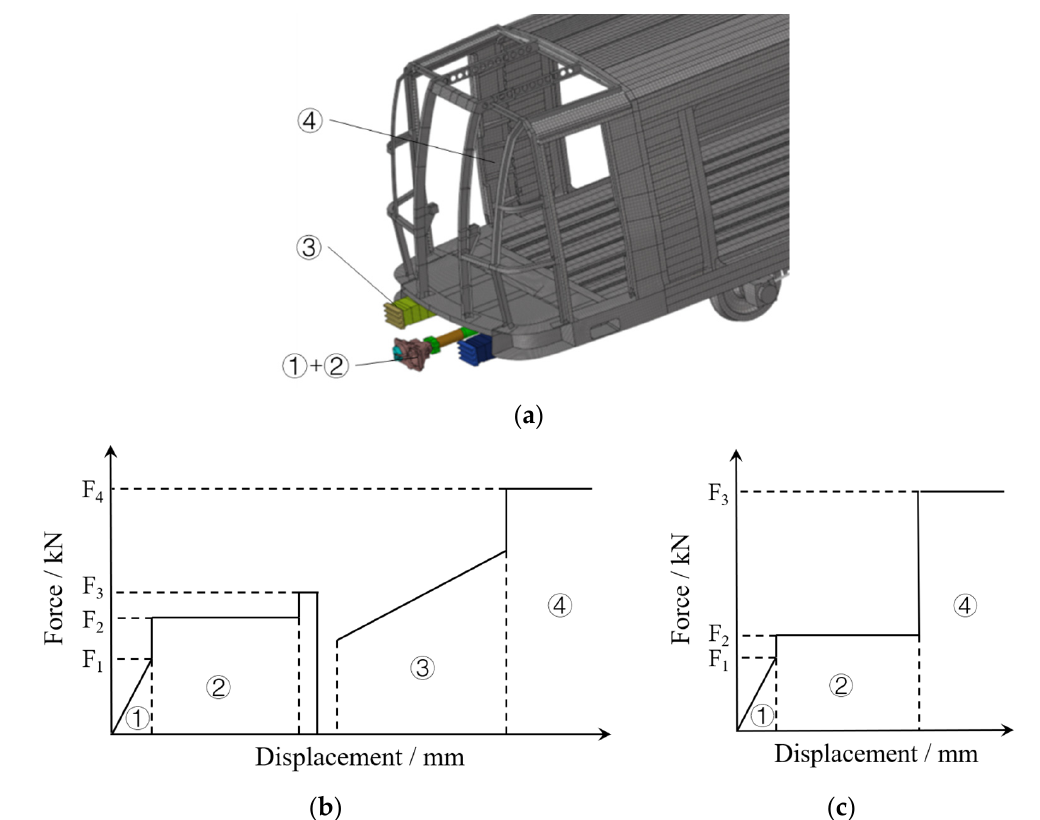
Figure 1. Energy absorption sequence of energy-absorbing structures: ( a ) energy-absorbing structures: ① draft gear ② collapse tube ③ anti-climbing device ④ car body, ( b ) the head car, ( c ) the middle car.